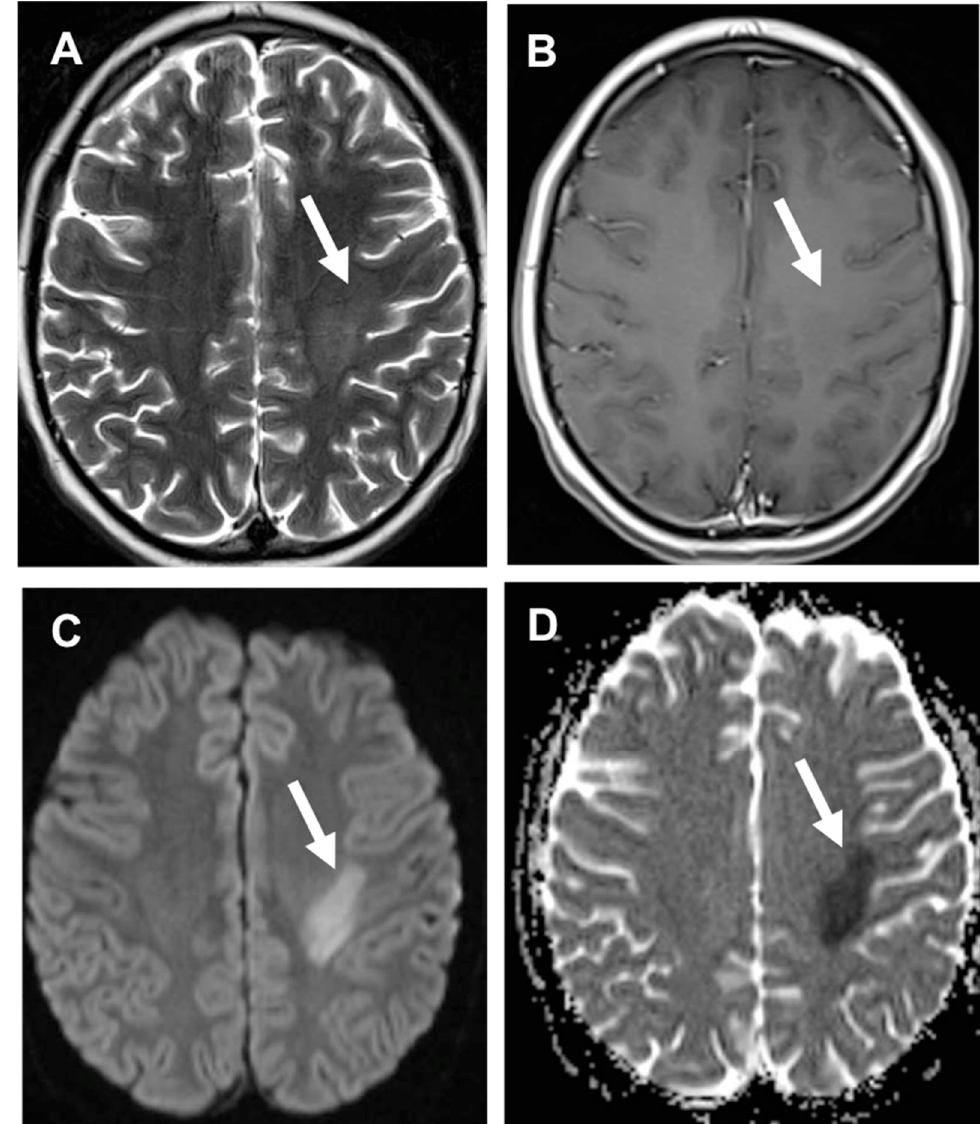
Figure 3. Methotrexate -Induced Neurotoxicity during childhood acute lymphoblastic leukemia (ALL) therapy. Axial T2 w ( A ) shows an asymmetric area of hyperintense signal in the left corona radiata/centrum semiovale (arrow) with restricted diffusion on DWI ( C ) and ADC map ( D ), and no enhancement after gadolinium administration ( B ).